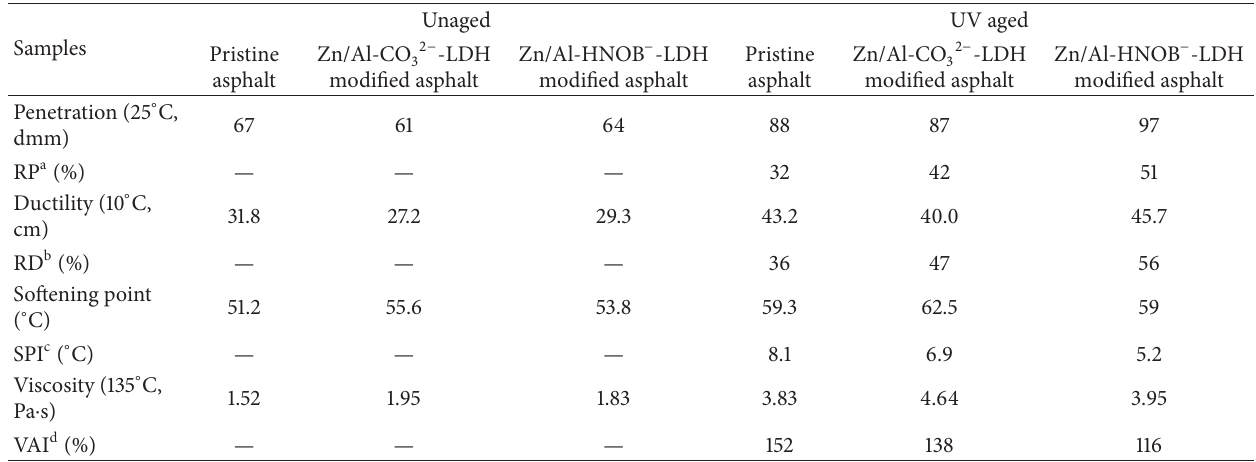
Table 3: Physical properties of asphalt binders before and after UV aging.